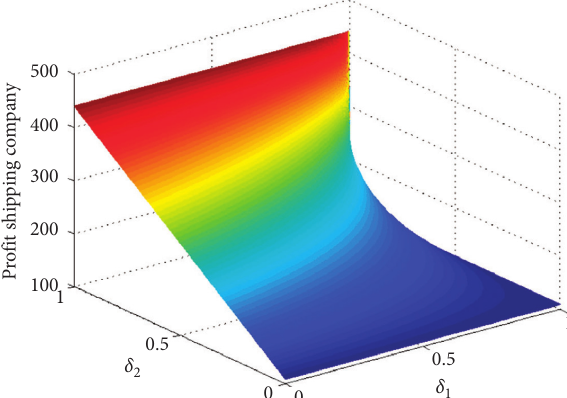
Figure 5: Revenue in the bargaining of shipping